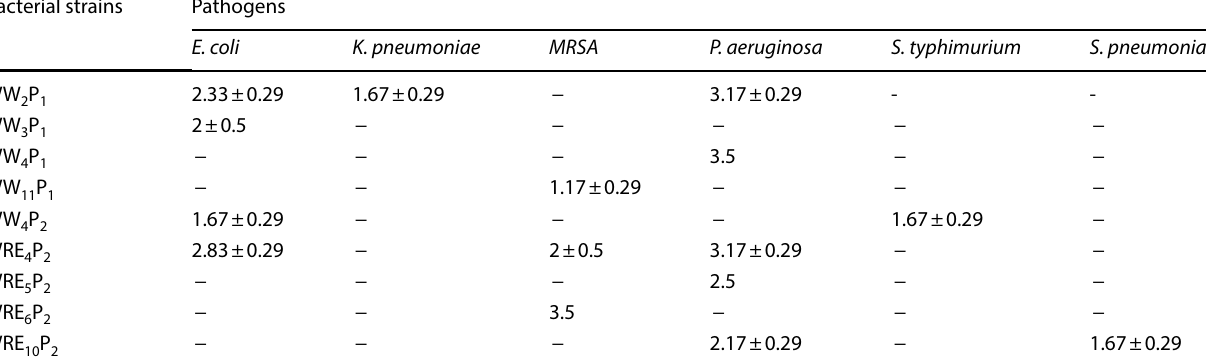
*Numbers in the table indicate zones in mm. MRSA: Methicillin-resistant Staphylococcus aureus , (-): no